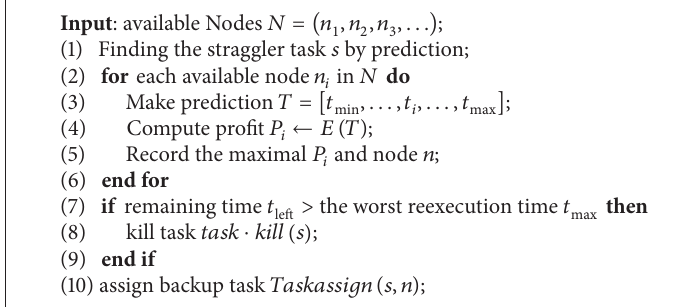
Algorithm 2: Algorithm for risk-aware assignment.